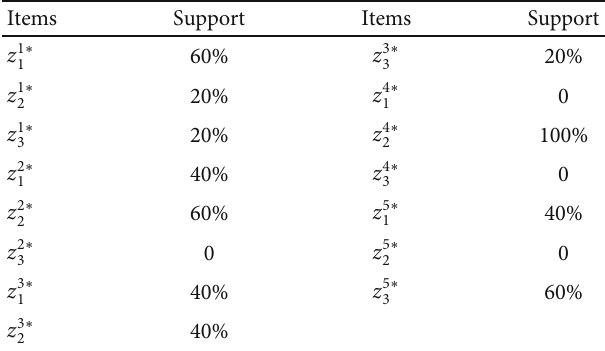
Table 7: Frequent item set L